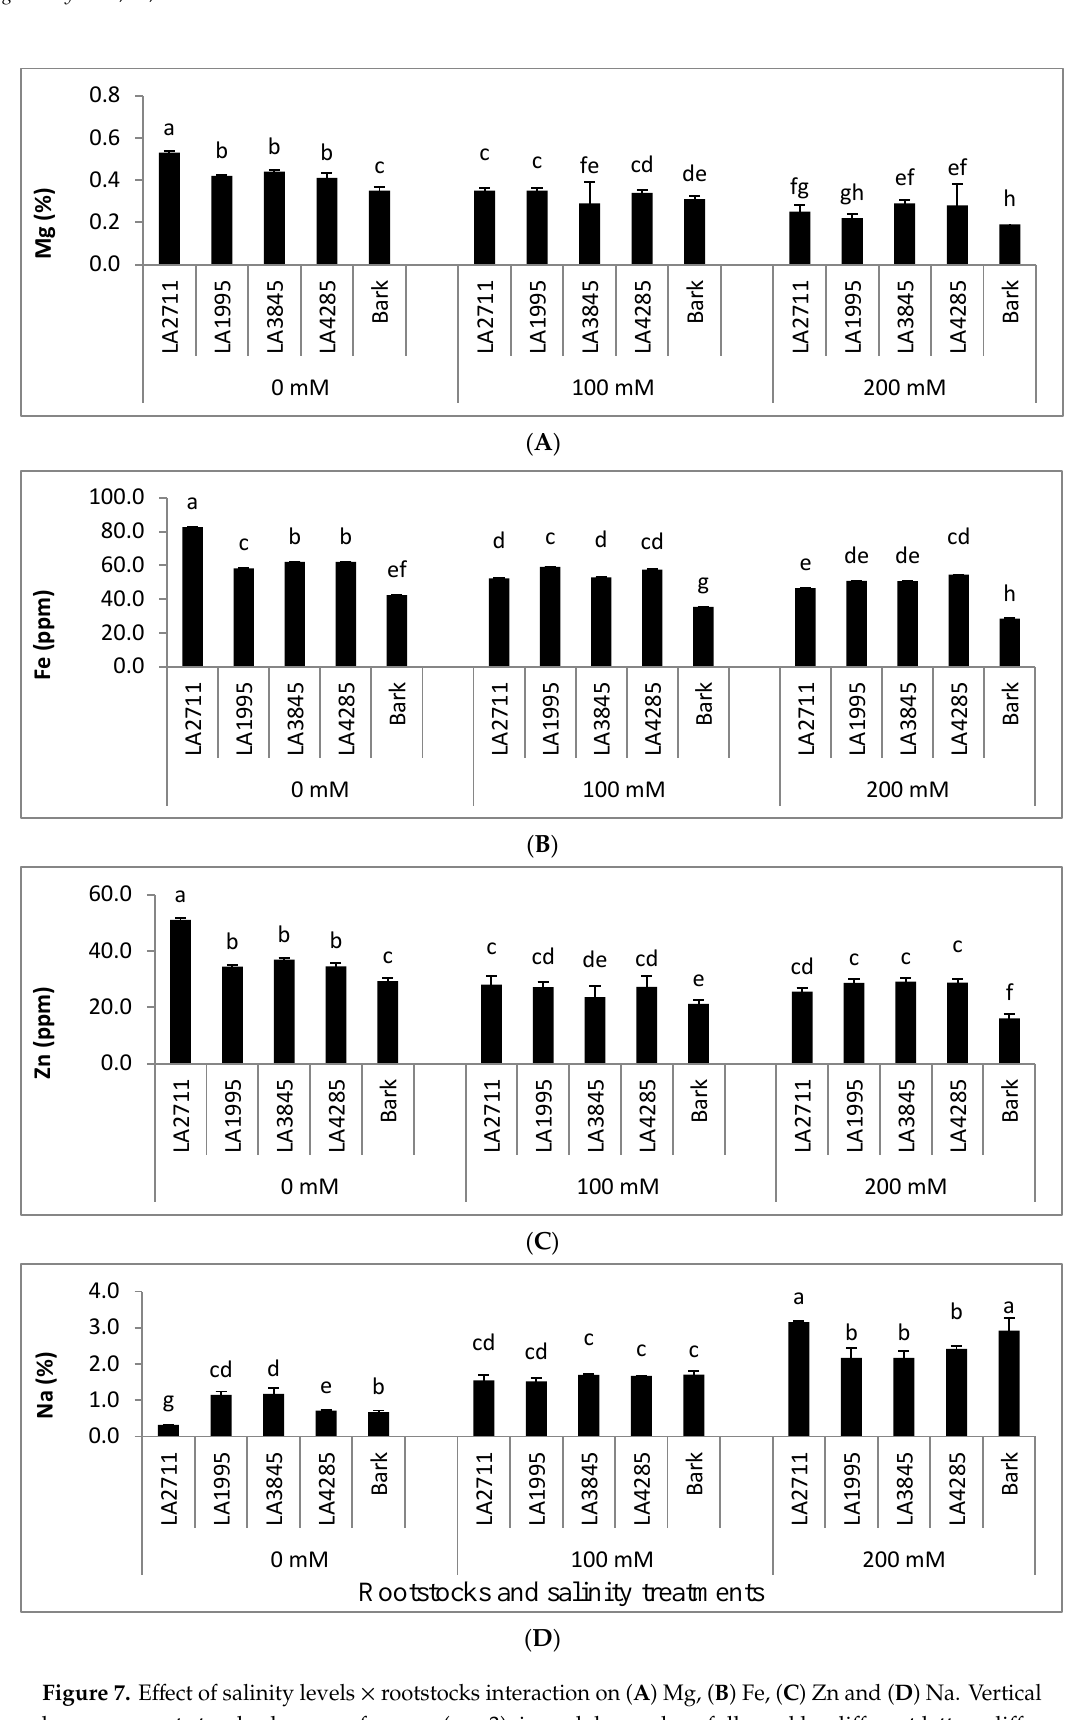
Figure 6. Effect of salinity levels × rootstocks interaction on ( A ) N, ( B ) P, ( C ) K and ( D ) Ca. Vertical bars represent standard errors of means ( n = 3); in each bar, values followed by different letters differ significantly at p = 0.05 according to Tukey test.